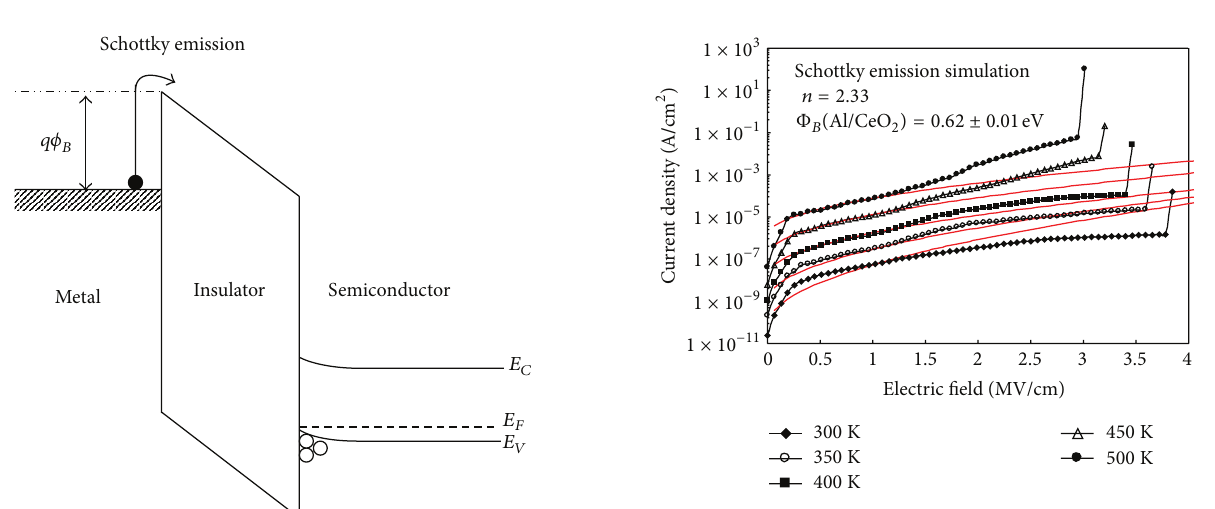
Figure 2: Schematic energy band diagram of Schottky emission in metal-insulator-semiconductor structure.